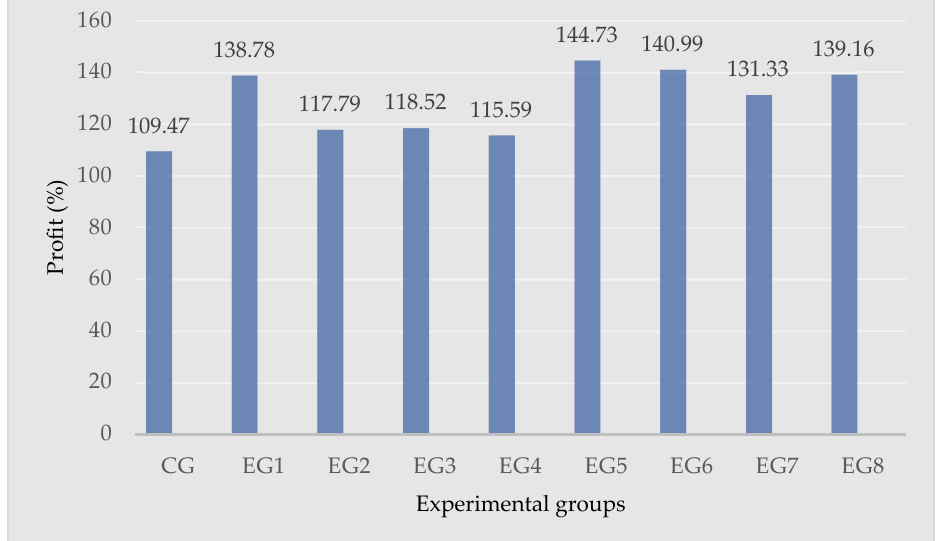
Figure 1. Comparation of profit obtained by using essential oil supplements in spring administered stimulation feeds of bee colonies. CG—control group (no essential oil supplement); EG1—Basil es-